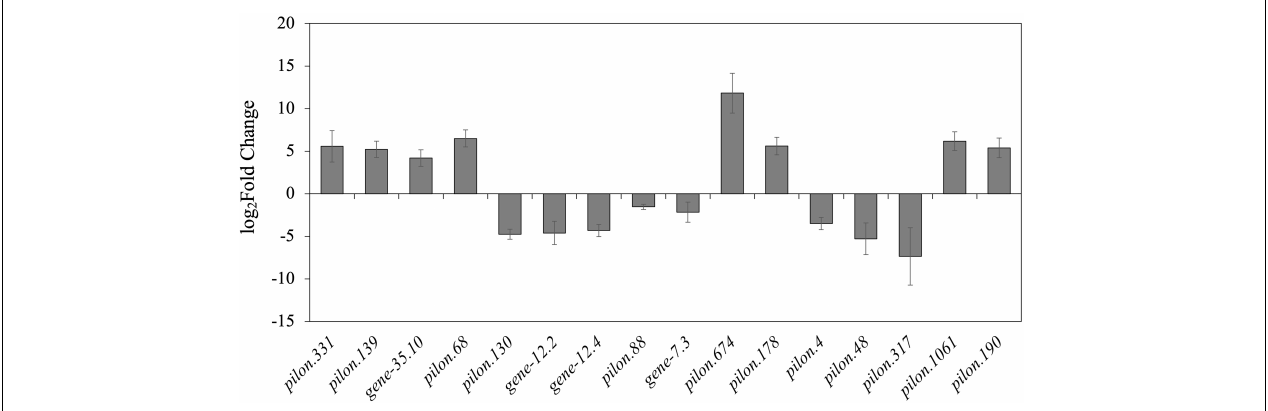
FIGURE 2 | Bar chart based on RT-qPCR validation of observed expression levels for eight upregulated or downregulated DEGs. The log 2 Fold change values of the RT-qPCR assay were calculated by the 2 − (cid:49)(cid:49) Ct method and shown with standard deviations from the